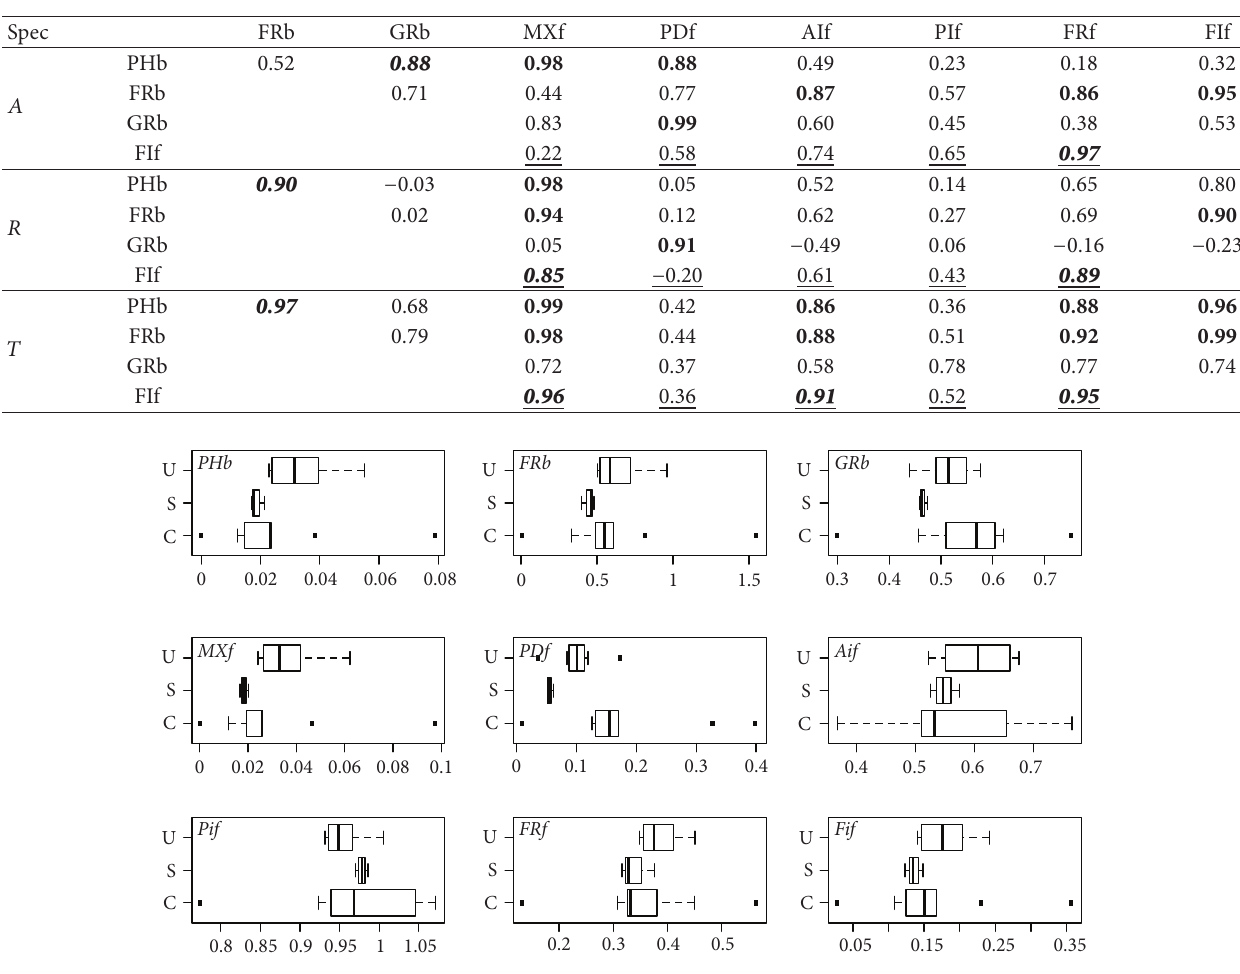
T 6: Correlation between spectral variables for all spectra (absorbance highlighted in bold. Italics denote high correlation between bands or between features. Underlined cells show correlations of FIf with other feature variables.